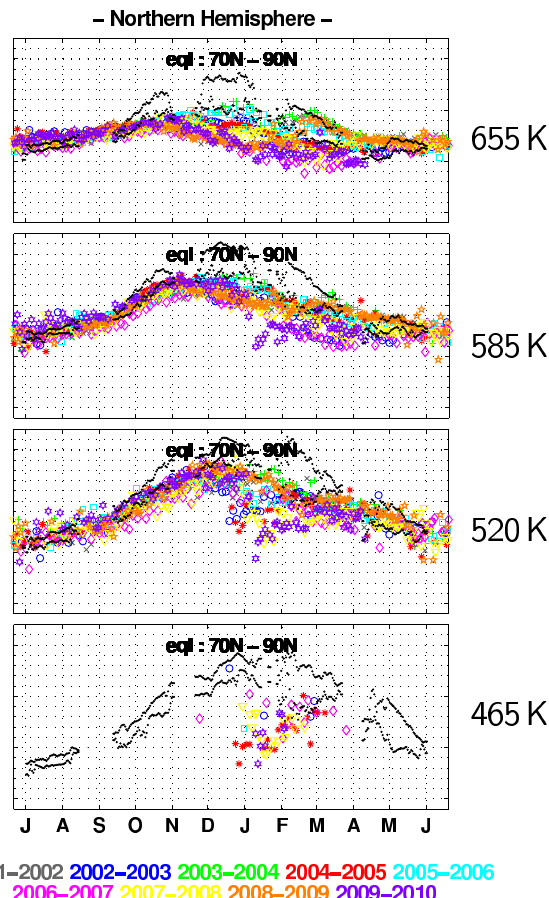
Fig. 4. Annual HNO 3 variability derived from Odin/SMR obser- vations at equivalent latitudes between 70 ◦ N and 90 ◦ N at potential temperature levels of 655, 585, 520 and 465K for the Arctic win- ters 2001/2002 to 2009/2010 (color) and the climatological mean derived from UARS/MLS (1991–1998) observation (black) at these potential temperature levels.